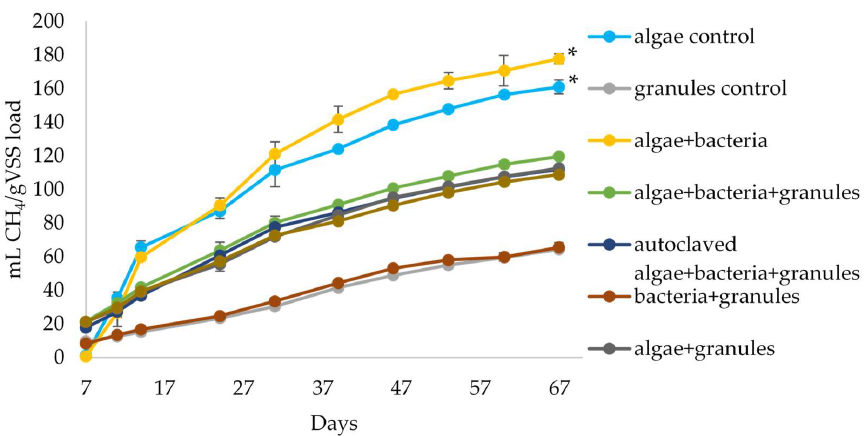
Figure 4. Cumulative specific methanogenic activity of augmented and non-augmented granular inoculum samples. Error bars represent standard deviations among triplicates. Datasets marked with asterisk (*) indicate statistically significant differences between the sets ( p < 0.0002).